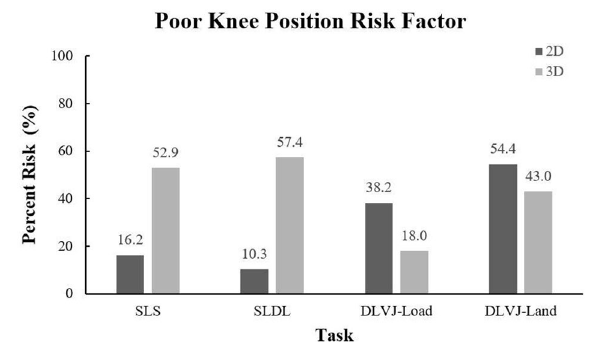
FIGURE 4 | 2D and 3D percent risk for the poor knee position risk